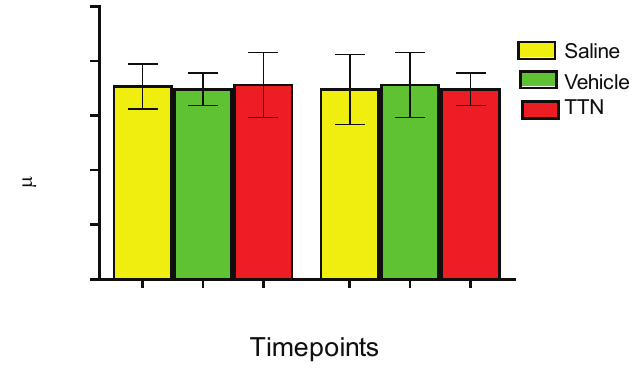
FIGURE 3 – Plasma concentrations of total antioxidants (micromoles) in saline, DMSO and ternatin (TTN) pretreated rats. Bars represent mean ± SD of control (yellow bars), vehicle (green bars) and TTN (red bars) groups at the end of the ischemia (T-0) and during reperfusion (T-3). Values were not different in T-0 and T-3